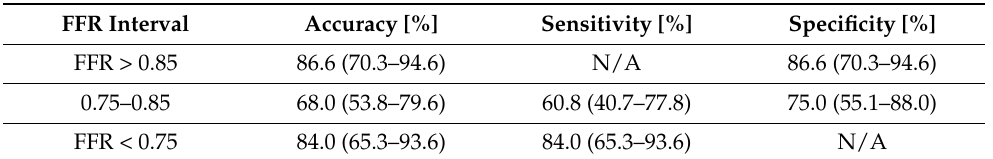
Table 6. Diagnostic performance and 95% CI of the model for lesions with FFR < 0.75, lesions with FFR > 0.85, and for the lesions with intermediate values.